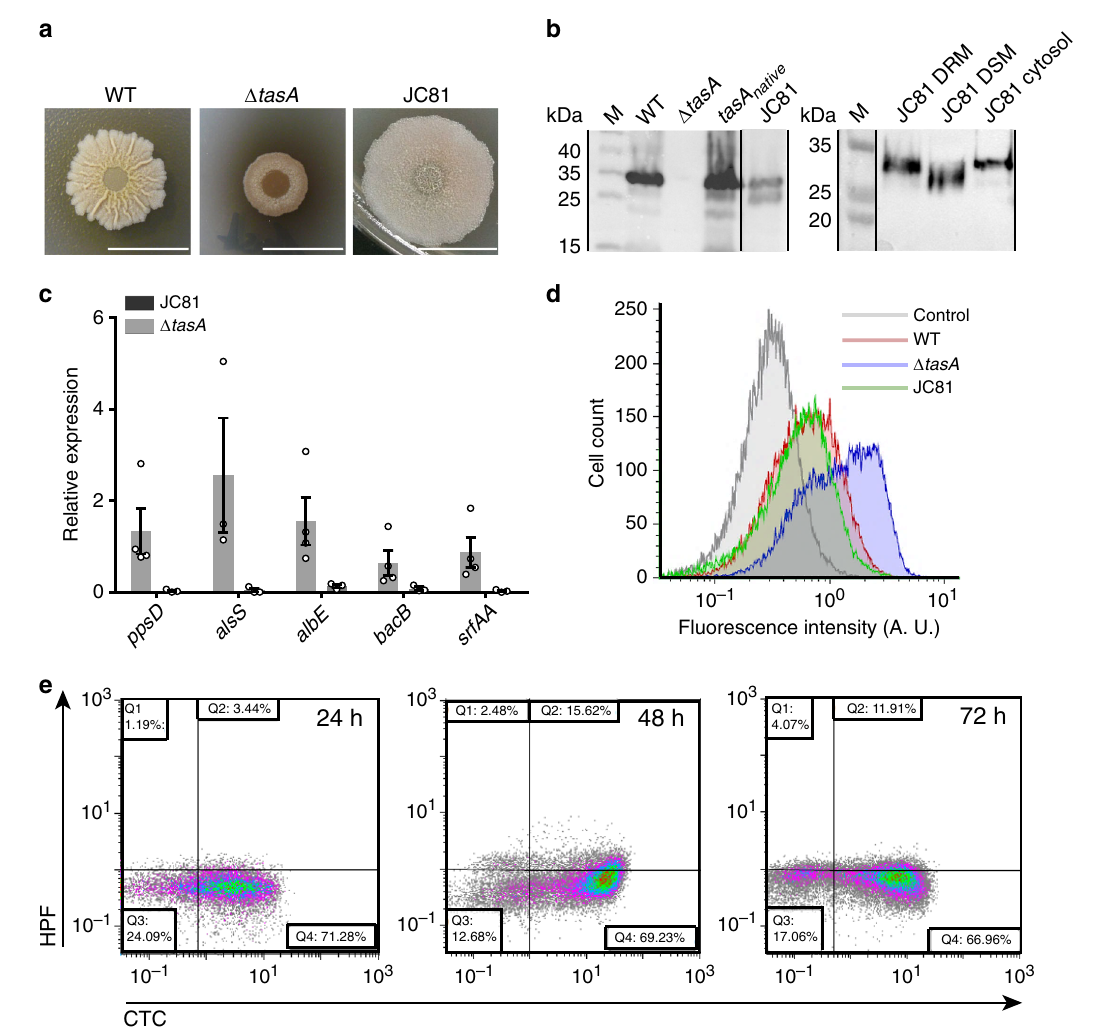
Fig. 9 A TasA variant rescues cellular physiological status but not bio fi lm. a Colony phenotypes of the three strains on MSgg agar at 72 h. Scale bars = 1 cm. b A western blot of the cell (left) and membrane fractions (right) at 72 h exposed to an anti-TasA antibody. Experiments have been repeated at least three times with similar results. Immunoblot images have been cropped and spliced for illustrative purposes. Black lines over the blot images delineate boundaries of immunoblot splicing. Two independents immunoblot images are shown. The two slices shown in the left image are derived from a single blot. The two slices shown in the right image are derived from a single blot. Raw images of the blots presented in this fi gure can be found in the source data fi le available with this manuscript. c Relative expression levels of ppsD , alsS , albE , bacB , and srfAA genes in JC81 compared to the WT strain. Average values of at least three biological replicates ( N = 3 except for ppsD, albE, bacB, and srfAA in Δ tasA , where N = 4) are shown with error bars representing the SEM. d Flow cytometry analysis of cells expressing the promoter of the fengyncin production operon in the WT, Δ tasA , JC81 strains at 72 h. A non- fl uorescent negative control corresponding to the unlabeled WT strain at 72 h is shown (gray). The fl ow cytometry data shown in Fig. 3 is from the same experiment as the data shown in this fi gure and are repeated here for comparative purposes with the data from strain JC81. e Density plots of cells double stained with the HPF (Y axis) and CTC (X axis) dyes show that JC81 behaved similarly to the WT